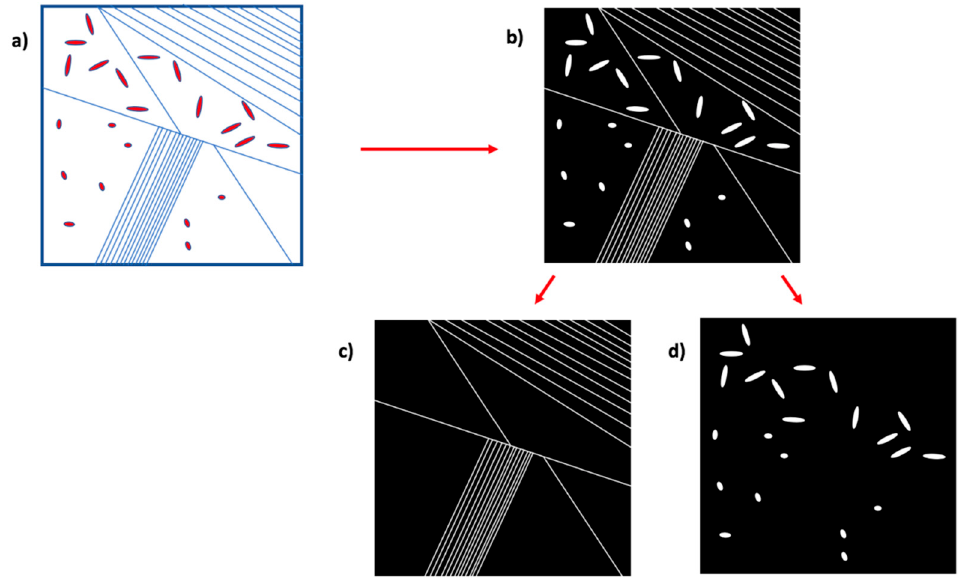
Figure 1. Schematic images showing the routine used to isolate the precipitates in field emission scanning electron microscopy (FE-SEM) images of auto-tempered martensite.